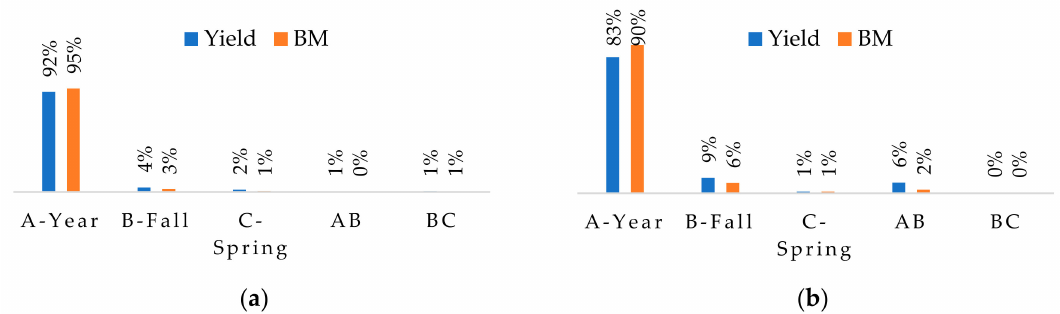
Figure 9. Contribution of the factors examined in the study on yield and biomass of Ingenio ( a ) and NS40S ( b ) varieties in the multiyear analysis